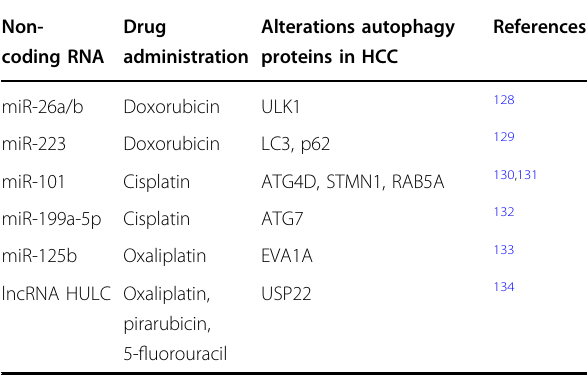
Table 1 Non-coding RNA in autophagy-related drug resistance of